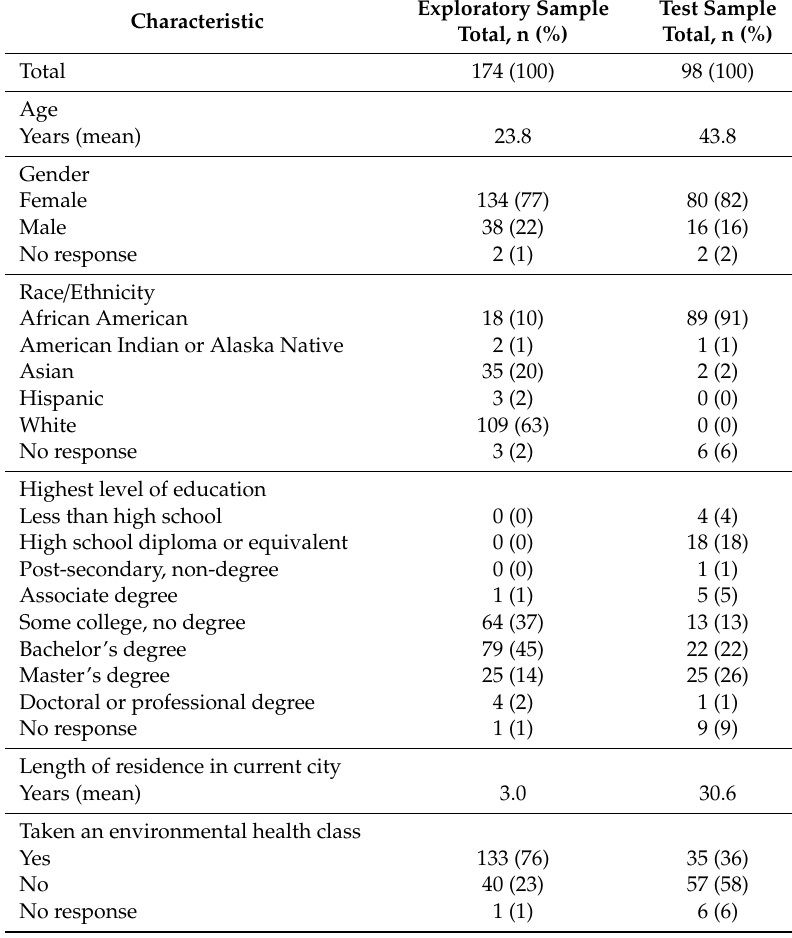
Table 1. Exploratory and test sample